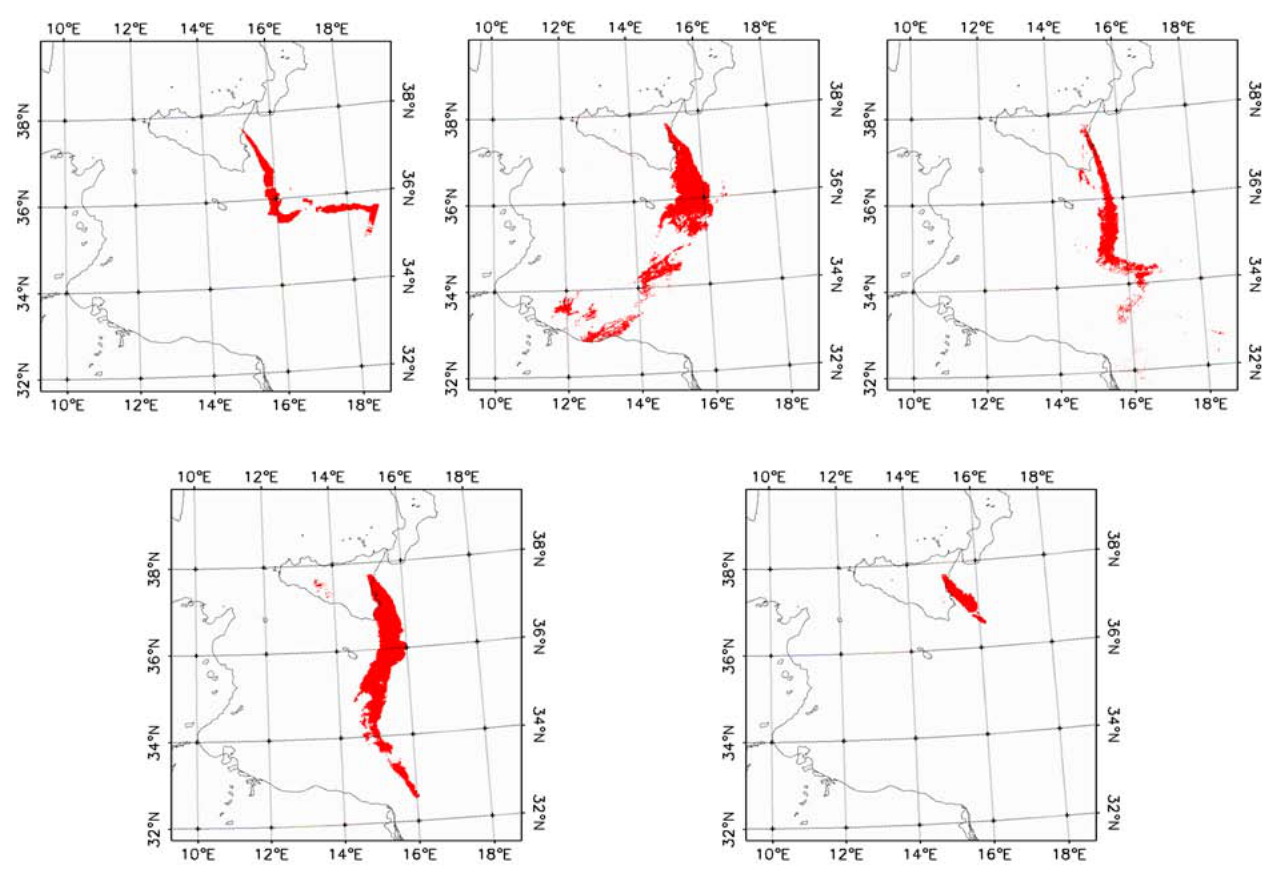
Fig. 2. MODIS BTD ash detection maps. Top Plates, from left to right: 23 July 2001, 28 October 2002 and 29 October 2002. Bottom Plates, from left to right: 30 October 2002 and 24 November 2006